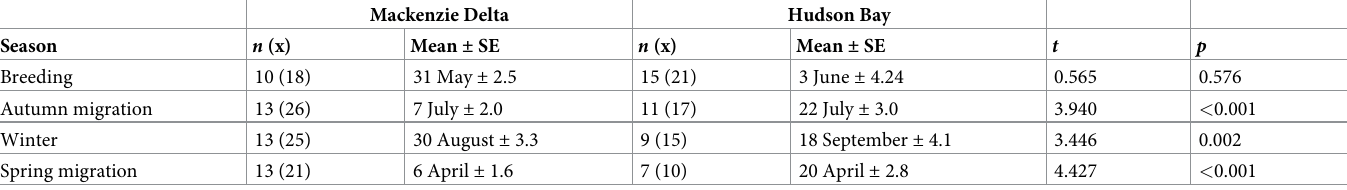
Table 2. Mean initiation dates of seasons for whimbrels from Mackenzie Delta and Hudson Bay breeding populations as determined by satellite tracking between 2008 and 2018. Mackenzie Delta Hudson